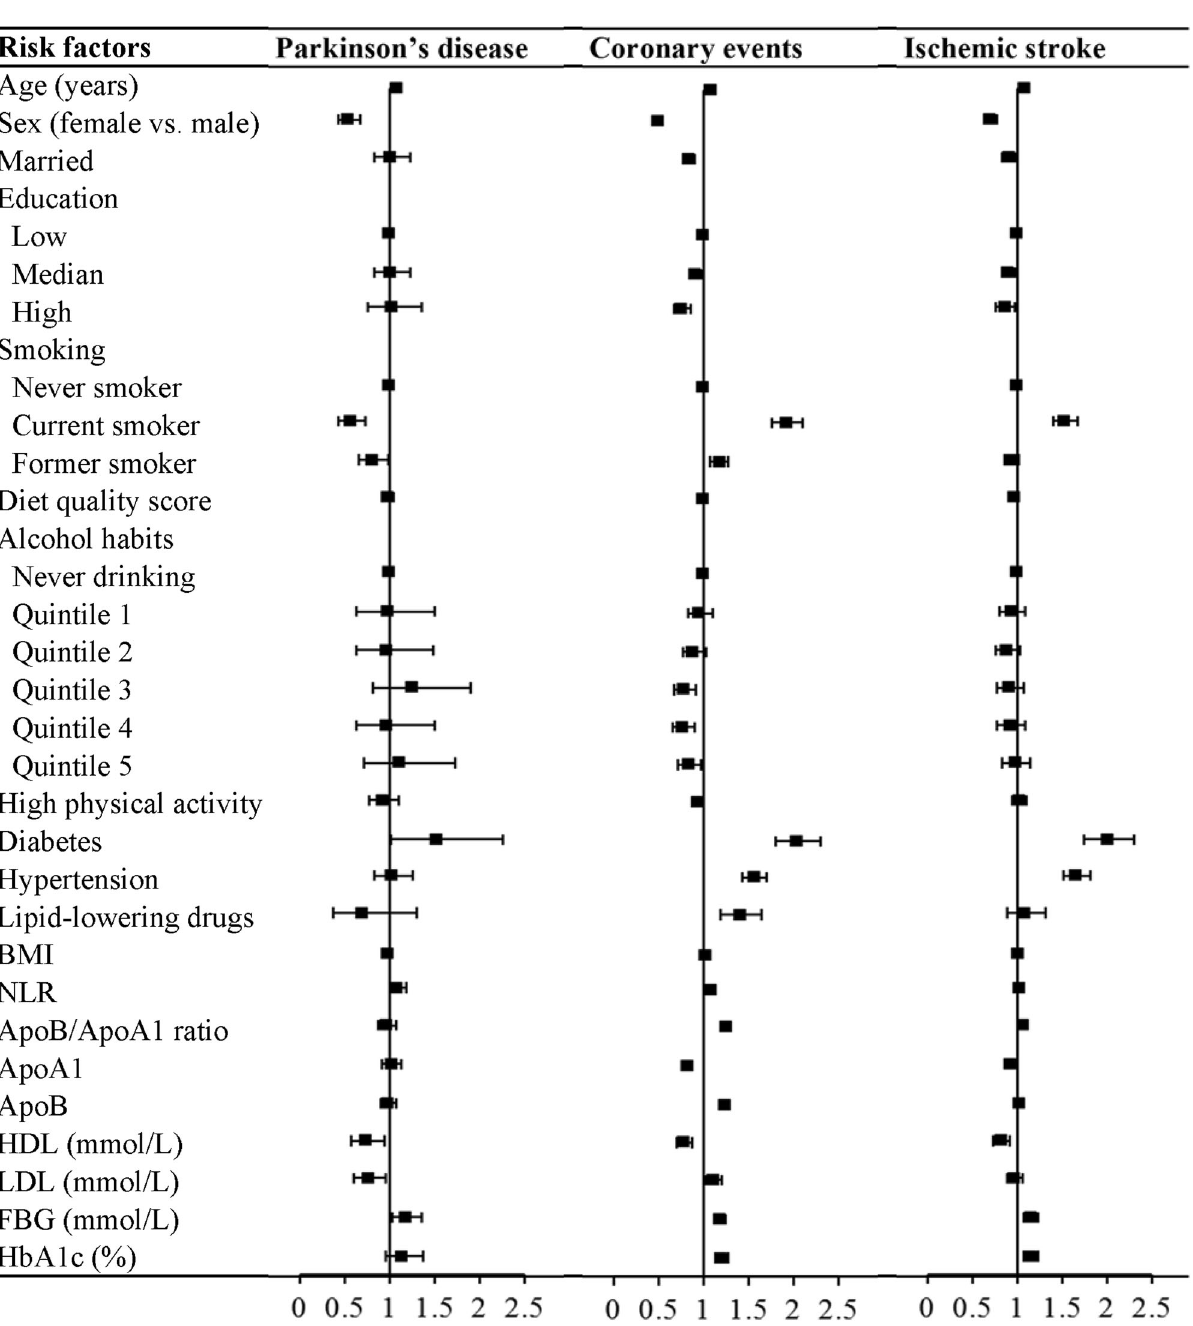
Fig. 1 Forest plot for the associations between risk factors and outcomes (Parkinson ’ s disease, coronary events, and ischemic stroke). Multivariable Cox proportional hazards model included age, sex, marital status, education, smoking, diet quality score, alcohol habits, physical activity, diabetes, hypertension, lipid-lowering drugs, BMI, NLR, apoB/apoA1 ratio, and total energy intake. When analyzing ApoA1 and ApoB or HDL and LDL, ApoB/ApoA1 ratio was removed from the model. When analyzing FBG and HbA1c (separately), diabetes was removed from the